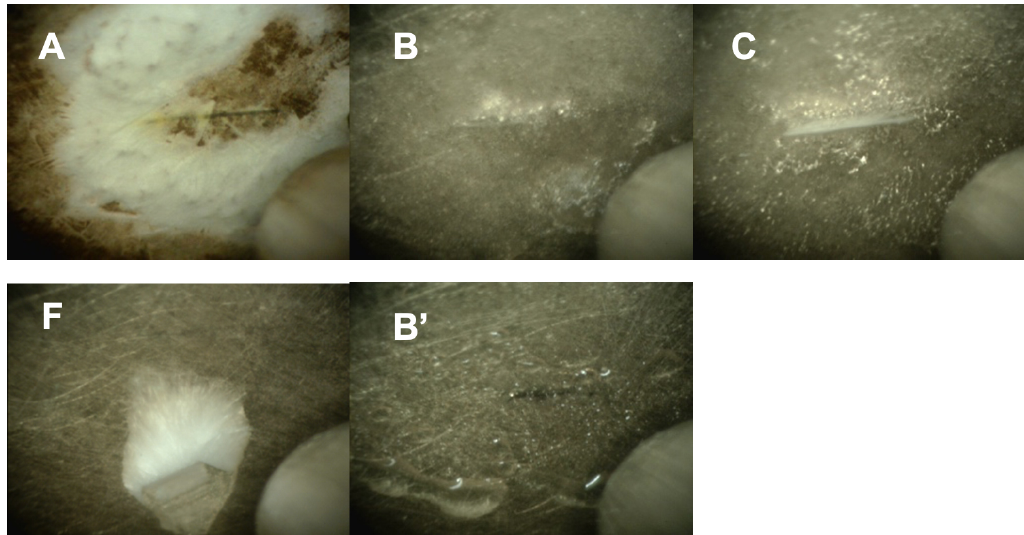
Figure 5. Optical microscopy pictures of the frozen samples. Each picture shows a 1mm wide section of the sample holder with the sample. The letters refer to the samples in Figs. 3 and 4: Sample A – solid NaCl at 248K and 44% relative humidity. Sample B – ice with brine at 88% RH and 259K. Picture B (cid:48) shows the deliquesced sample prior to freezing. Sample C – sample below the eutectic temperature at 248 to 249K in the presence of ice. Sample F – sample in the absence of ice at a relative humidity lower than 73% and at 244K. Pictures of samples D and E were not